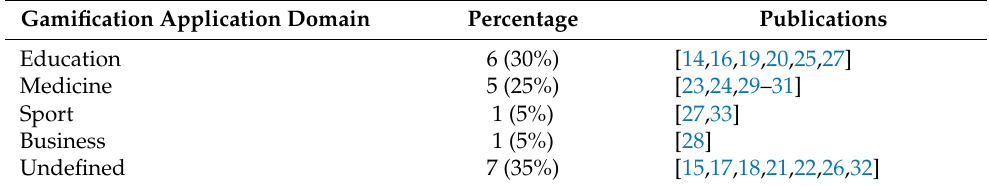
Table 3. Distribution of papers based on the gamification application domain.